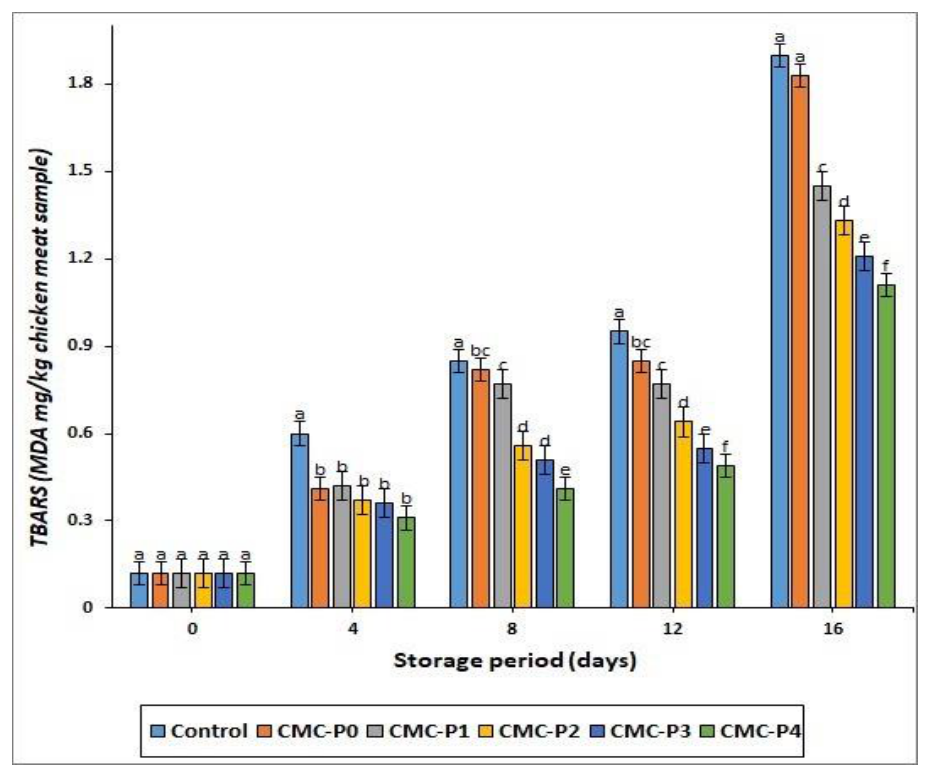
Figure 5. The impact of applied coatings on the TBARS values (MDA mg/kg chicken breast meat sample) of chicken breast meat samples during storage at 2 °C for 16 days. Control : Uncoated chicken breast meat samples (soaked samples in sterile distilled water). CMC-P0 : CMC-coated chicken breast meat samples with 0% EPE. CMC-P1 : CMC-coated chicken breast meat samples with 1% EPE. CMC-P2 : CMC-coated chicken breast meat samples with 2% EPE. CMC-P3 : CMC-coated chicken breast meat samples with 3% EPE. CMC-P4 : CMC-coated chicken breast meat samples with 4% EPE. a – f : Within a column, different superscripts indicate significant differences ( p ≤ 0.05 ).